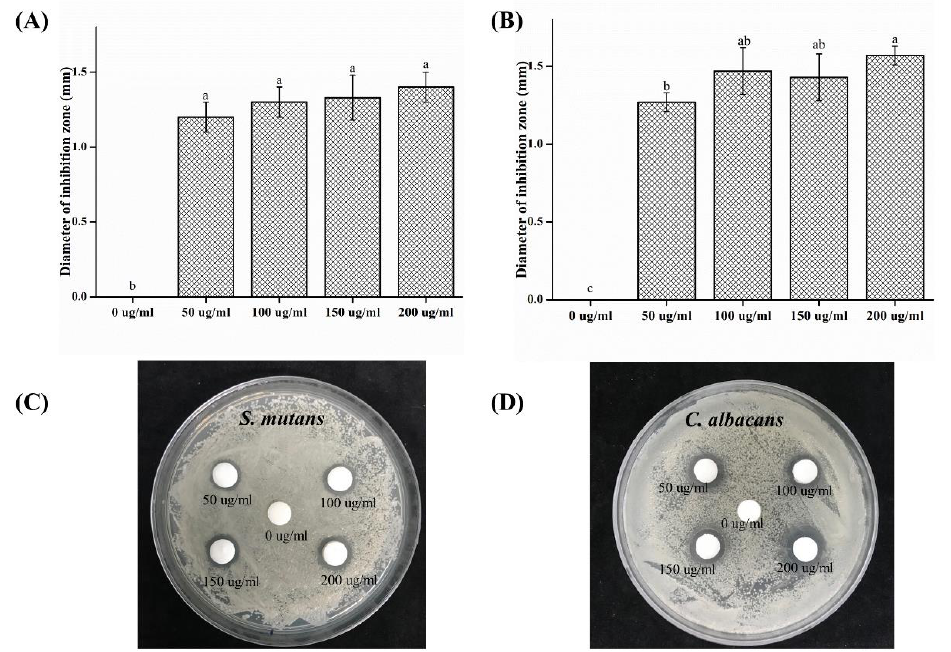
Figure 1. Comparison of the antimicrobial properties between different groups. The diameters of the zone of inhibition on the agar plate were measured for ( A ) S. mutans and ( B ) C. albicans . Images of the inhibition zone test on agar plates with ( C ) S. mutans and ( D ) C. albicans . Different letters above bars indicate significant differences ( p < 0.05).